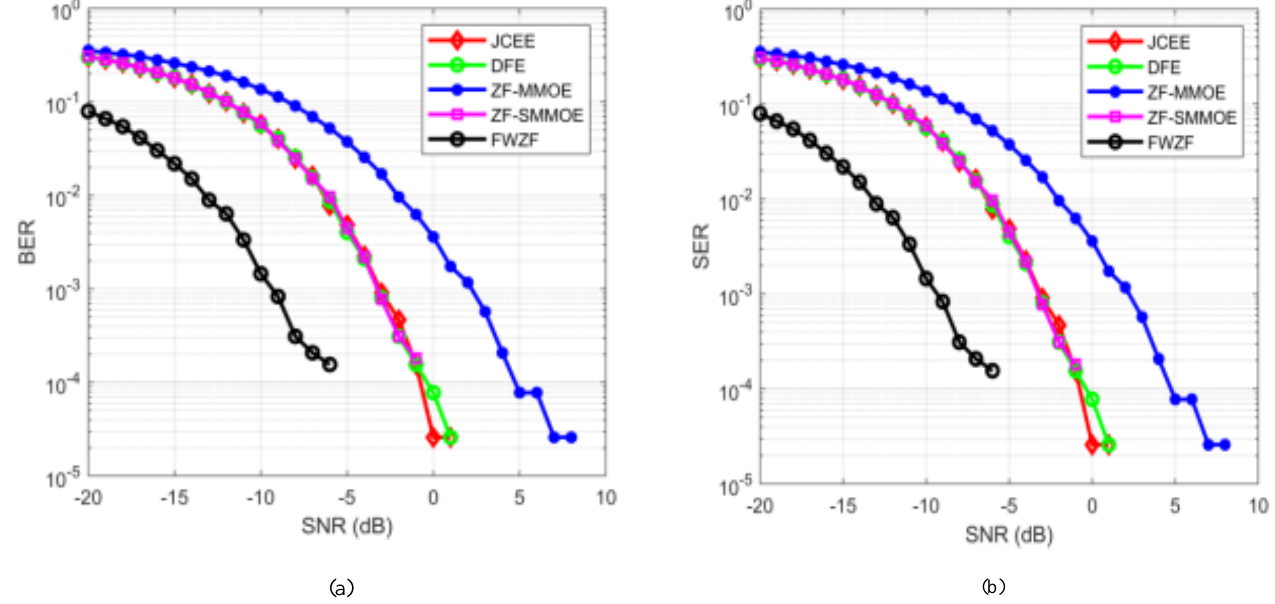
Fig. 5.Comparative analysis using antenna=5 in Rician channel, (a) BER, (b)